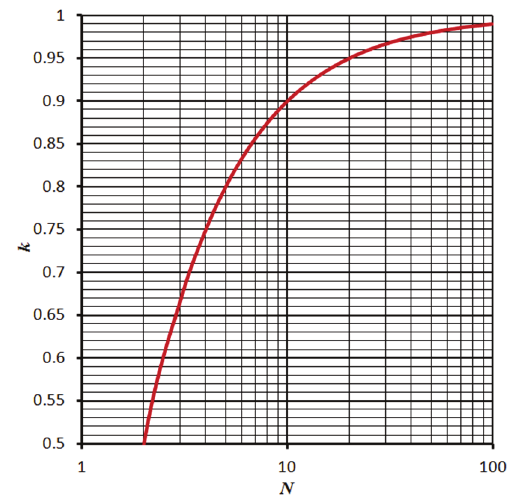
Fig. 2. Possible values of the isodromic coefficient k